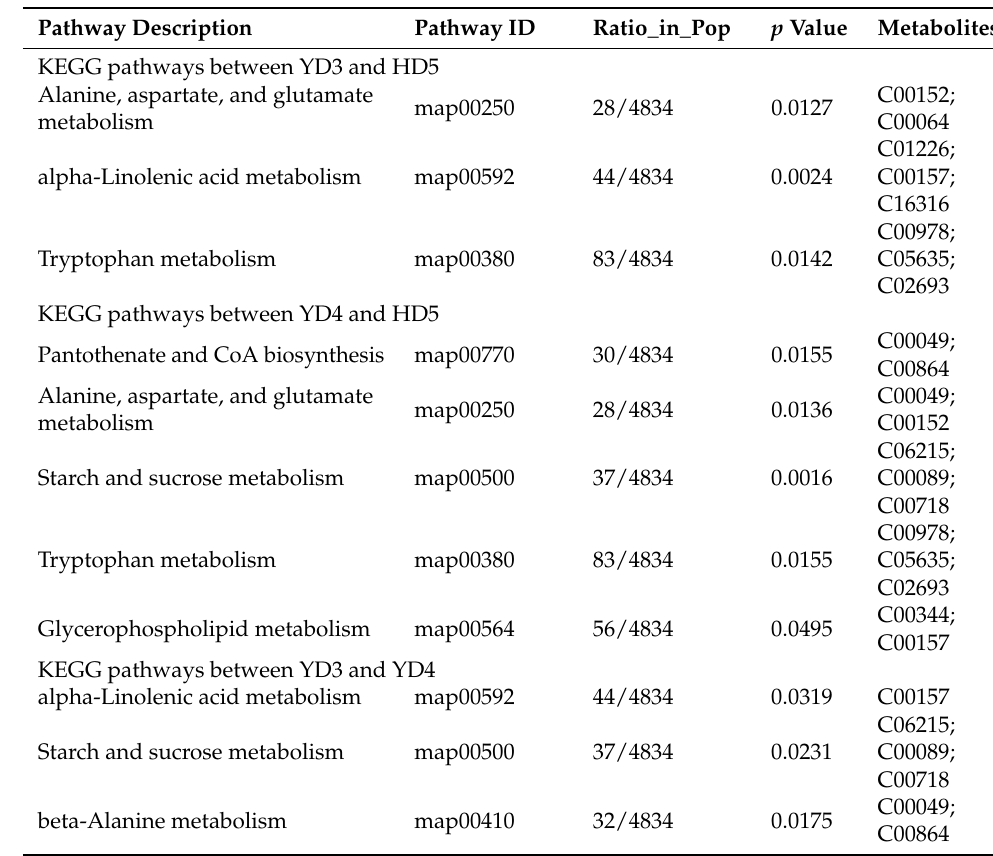
Table 2. KEGG pathways associated with DMs.